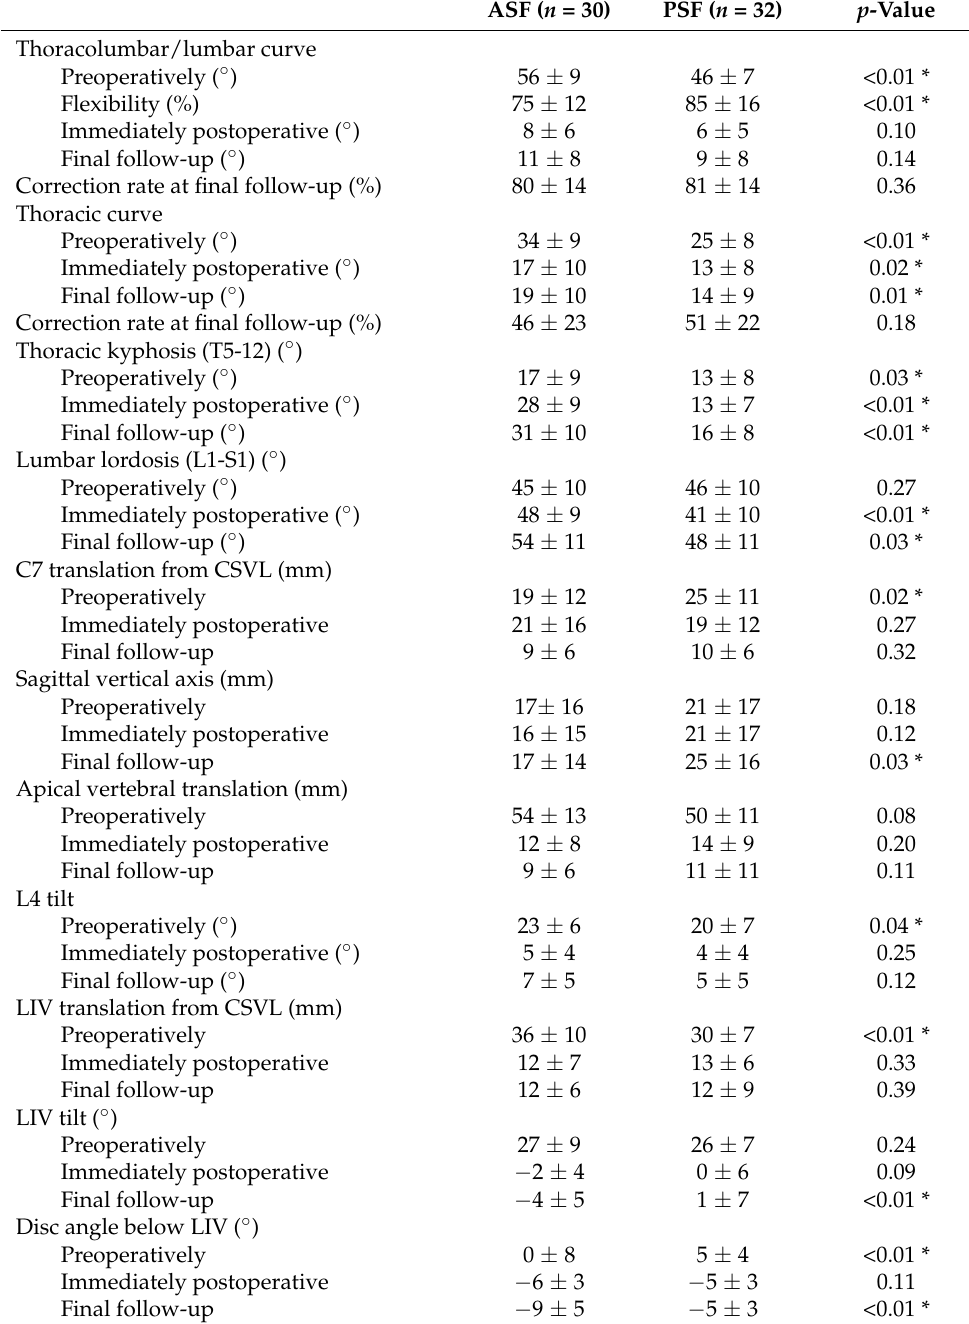
Table 3. Radiographic parameters of ASF and PSF